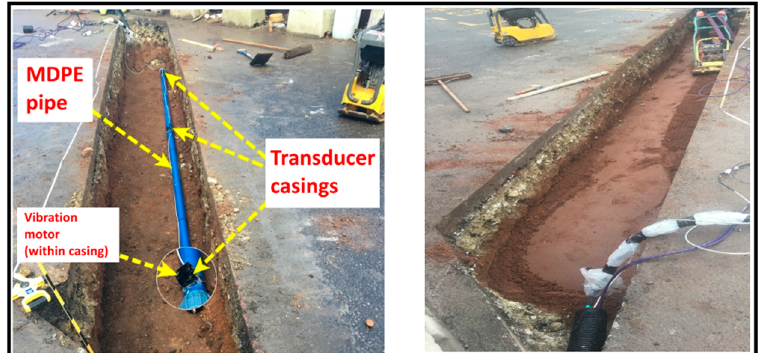
Figure 4. Buried plastic pipe before and after soil